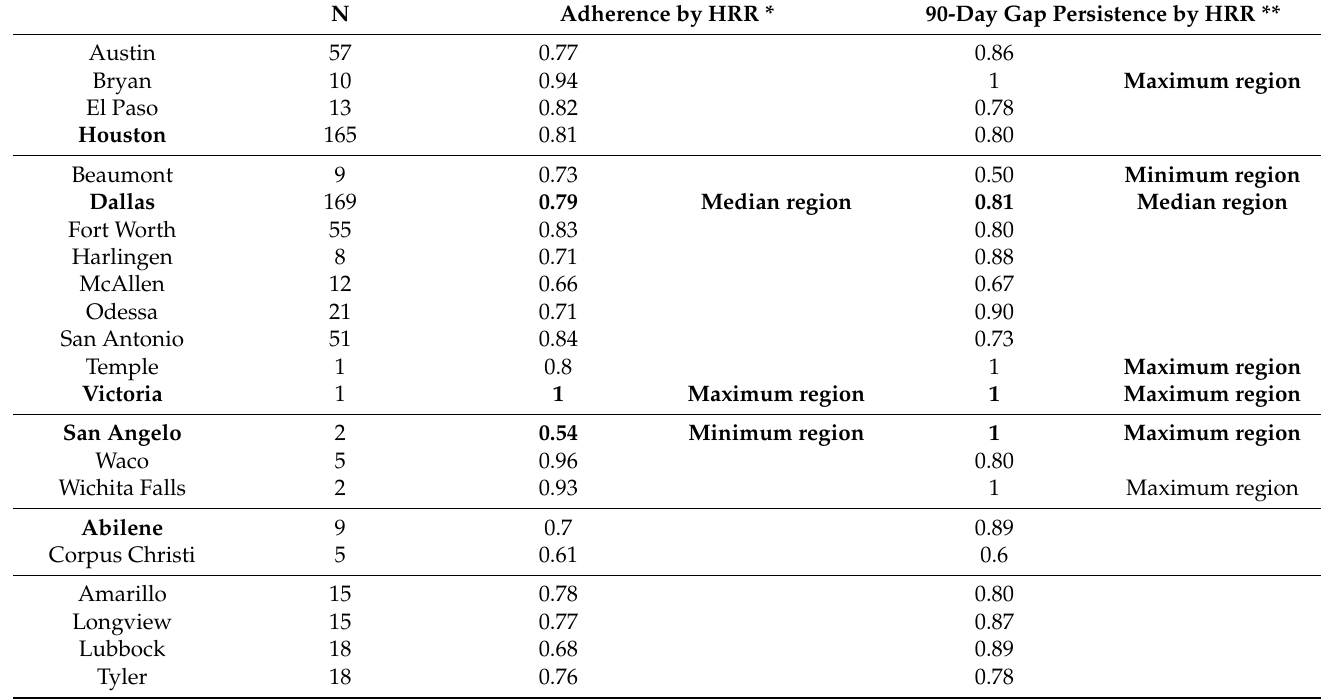
Table 2. Mean AHT adherence and persistence rates by